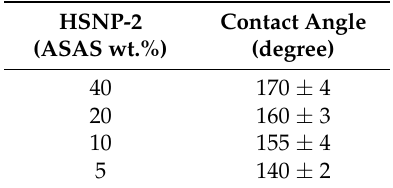
Figure 8. Optical micrographs of ( a ) HSNP-1 and ( b ) HSNP-2. Table 1. Advancing contact angles of water droplets on HSNP-2 surfaces at 25 °C.